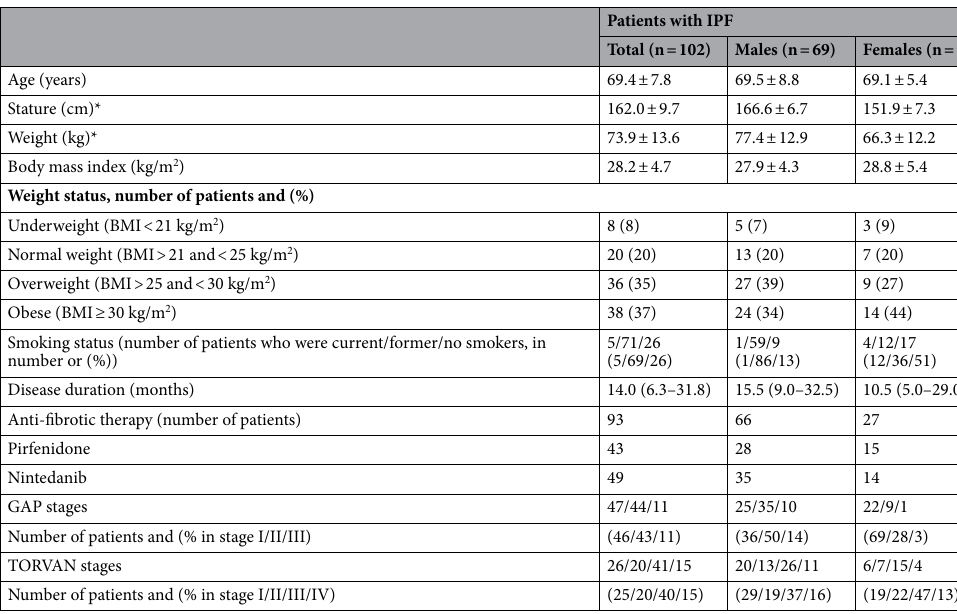
Table 1. Demographic and clinical characteristics of the 102 patients with idiopathic pulmonary fibrosis (IPF) participating in the study. Data are expressed as mean ± SD, median value (and interquartile range), or frequency, where appropriate. GAP = gender-age-physiology. * p < 0.05 between genders.